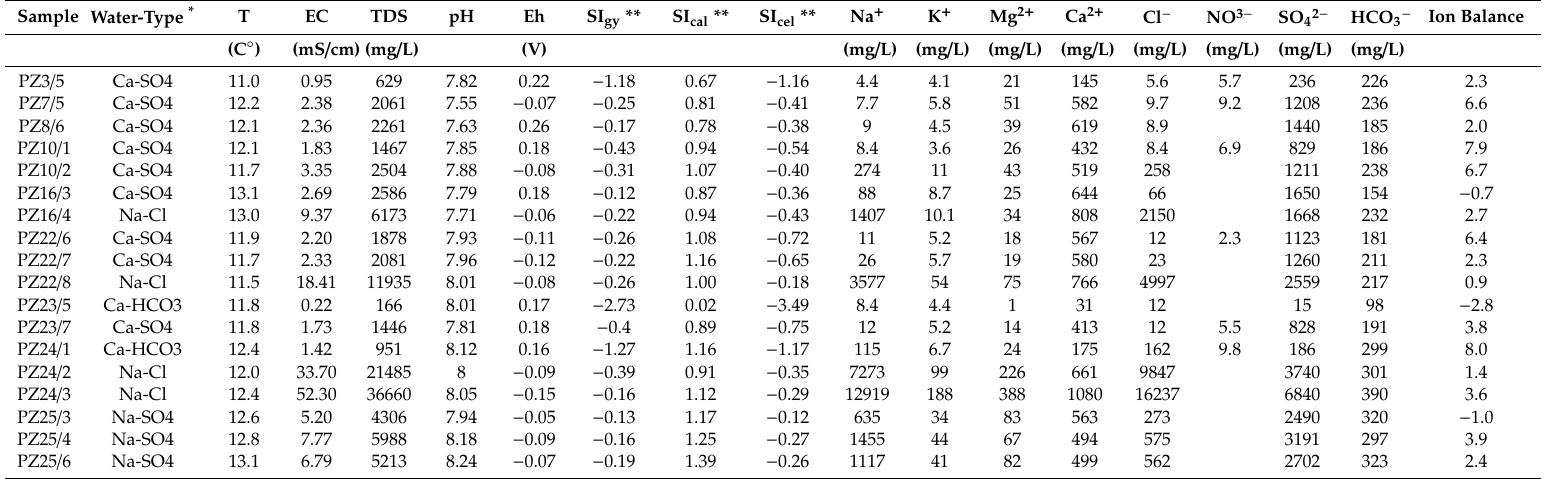
Table 2. Water-type, physico-chemical parameters (EC = electrical conductivity, Eh = redox potential, TDS = total dissolved solid) and major ions concentration. Sample Water-Type